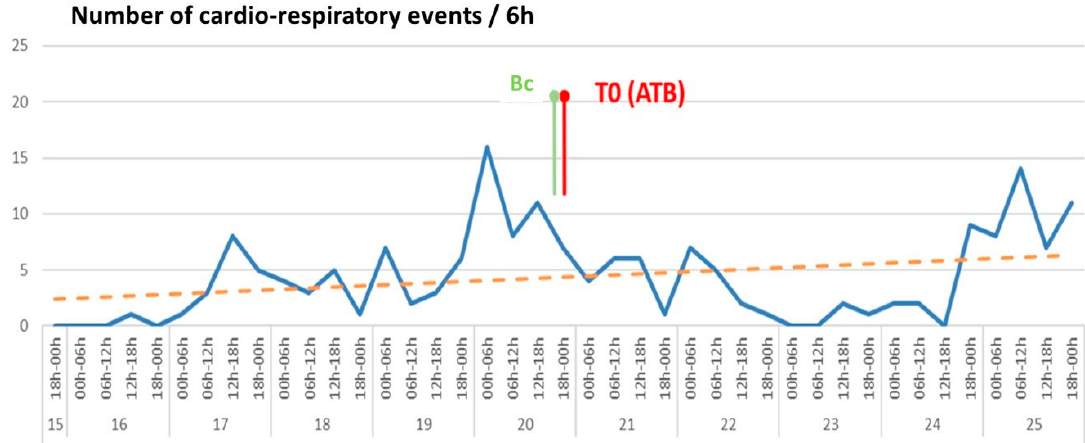
Figure 1. Number of cardio-respiratory events presented by 6 h period (blue line) for one very preterm infant. This figure gives an example of the user-friendly presentation of the results to the adjudication committee. Bc: time of first blood culture, which corresponds to the time of clinical suspicion; T0 (ATB): time of first antibiotic administration; dotted orange line: linear regression of the tendency during the study period. Vertical axis: number of cardio-respiratory events/6 h. Horizontal axis: date and 6 h-time intervals.